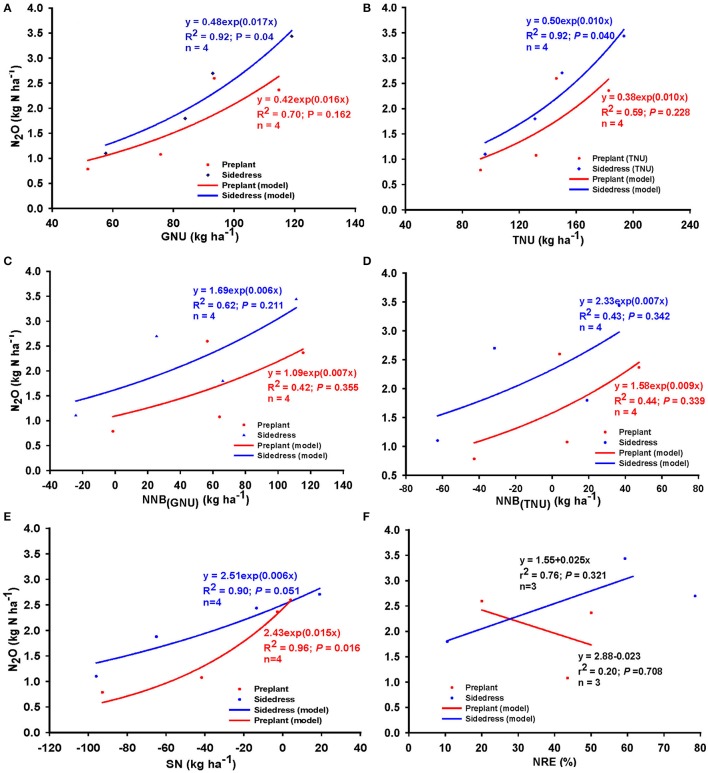
Relationship between nitrous oxide (N2O) emission and (A) grain N uptake (GNU), (B) total N uptake (TNU), net N balance for (C) grain N [NNB(GNU)] (D) total N uptake [NNB(TNU)] and (E) surplus N (SN), and (F) N recovery efficiency (NRE) when N was applied preplant/at planting and early sidedress (V6) across Indiana (United States) and New Brunswick (Canada). n = number of N rate groups, and points within each n group are mean values of 4, 4, 2, and 4 observations, respectively.